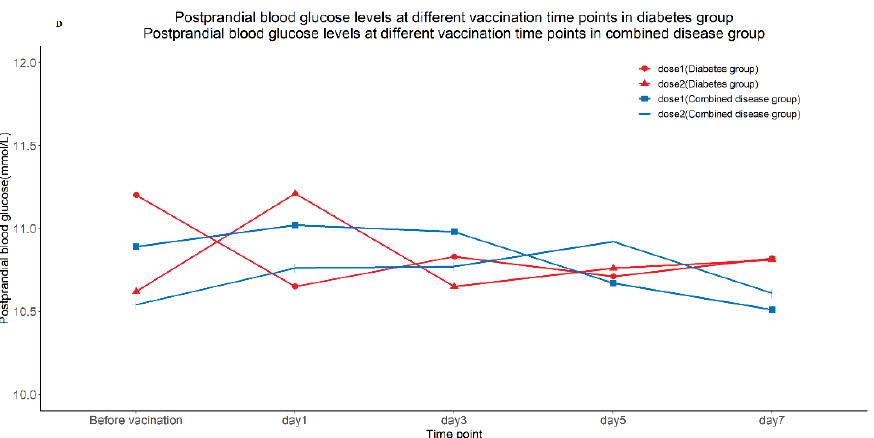
Figure 3. The blood pressures and blood glucose levels at different vaccination time points. ( A ) Sys- tolic blood pressure levels at different vaccination time points in hypertension group and combined disease group. ( B ) Diastolic blood pressure levels at different vaccination time points in hypertension group and combined disease group. ( C ) Fasting blood glucose levels at different vaccination time points in diabetes group and postprandial blood glucose levels at different vaccination time points in combined disease group. ( D ) Postprandial blood glucose levels at different vaccination time points in diabetes group and combined disease